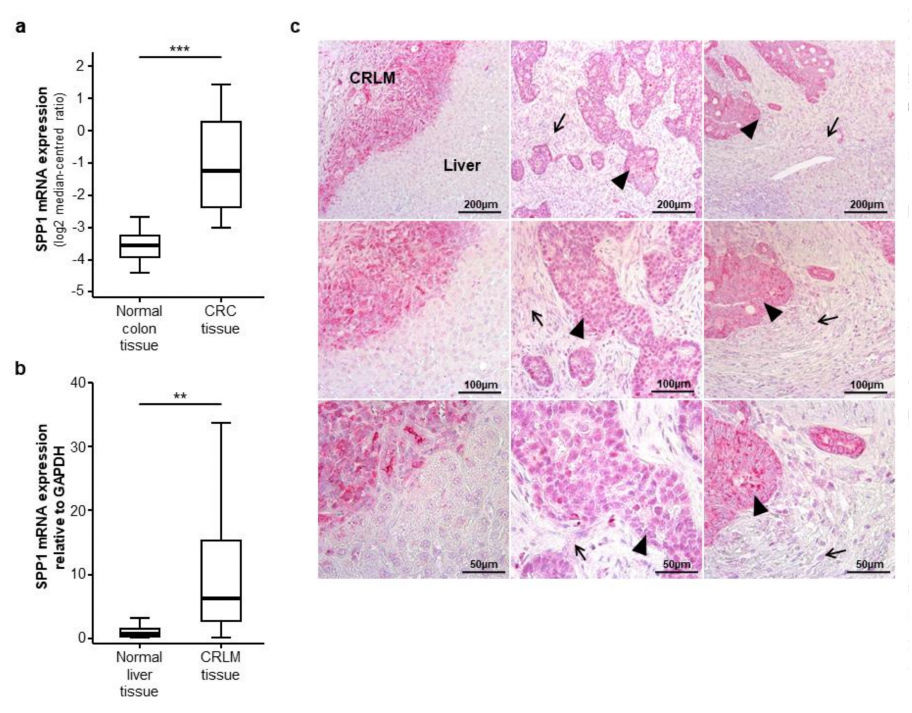
Figure 1. Osteopontin (SPP1) is overexpressed in colorectal liver metastases. ( a ) Osteopontin (SPP1) mRNA expression levels are strongly elevated in colorectal cancer (CRC) tumour samples compared to normal colon tissue samples ( u -test, p (***) < 0.001); ( b ) SPP1 mRNA expression levels are significantly elevated in colorectal liver metastases (CRLM) tissue samples compared to normal liver tissue ( u -test, p (**) < 0.01); ( c ) Immunohistochemical osteopontin staining in three exemplary CRLM samples (left, middle and right column). Left column: osteopontin is highly expressed in CRLM compared to normal liver tissue; middle and right column: tumour cells show a strong osteopontin expression (black arrow heads) while the peritumoral stromal tissue displays a weak osteopontin signal (black arrows); (upper panel: 100-fold magnification, middle panel: 200-fold magnification, lower panel: 400-fold magnification).